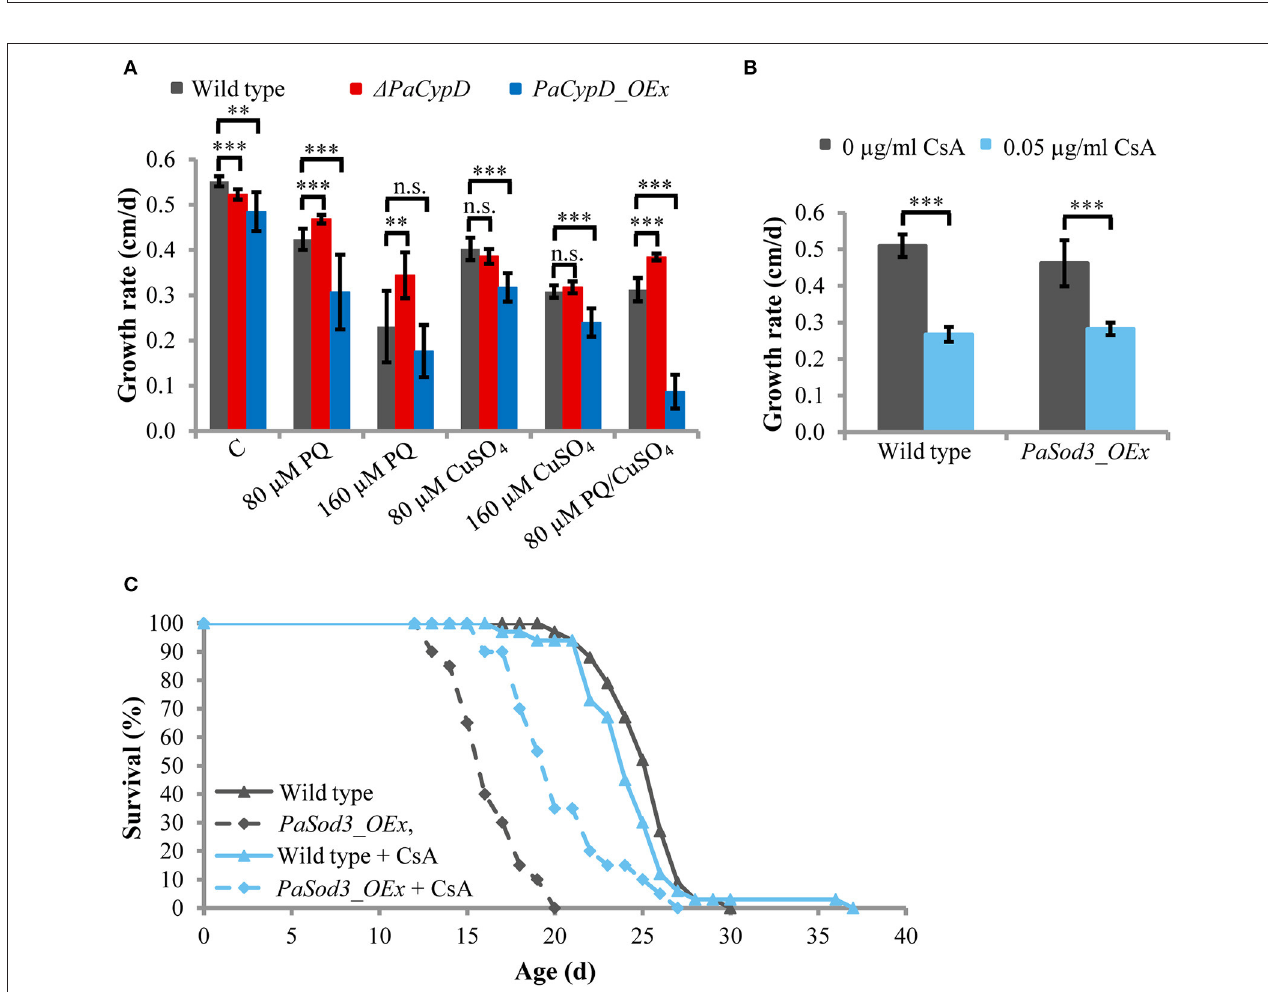
FIGURE 3 | (A) The growth rate of 2 d old wild-type, ∆ PaCypD and PaCypD_OEx strains ( n = 10) was monitored for 13 d on M2 medium in the presence of the ROS stressors paraquat (PQ), CuSO 4 , both or without ROS stressors (control: C). (B) Growth rate and (C) lifespan of wild type ( n = 33) and PaSod3_OEx ( n = 20) on M2 medium with 0 or 0.05 µ g/ml cyclosporine A. Data represent average ± SEM (2-tailed student’s t -test). Not significant (n.s.), ** P < 0.01, *** P <